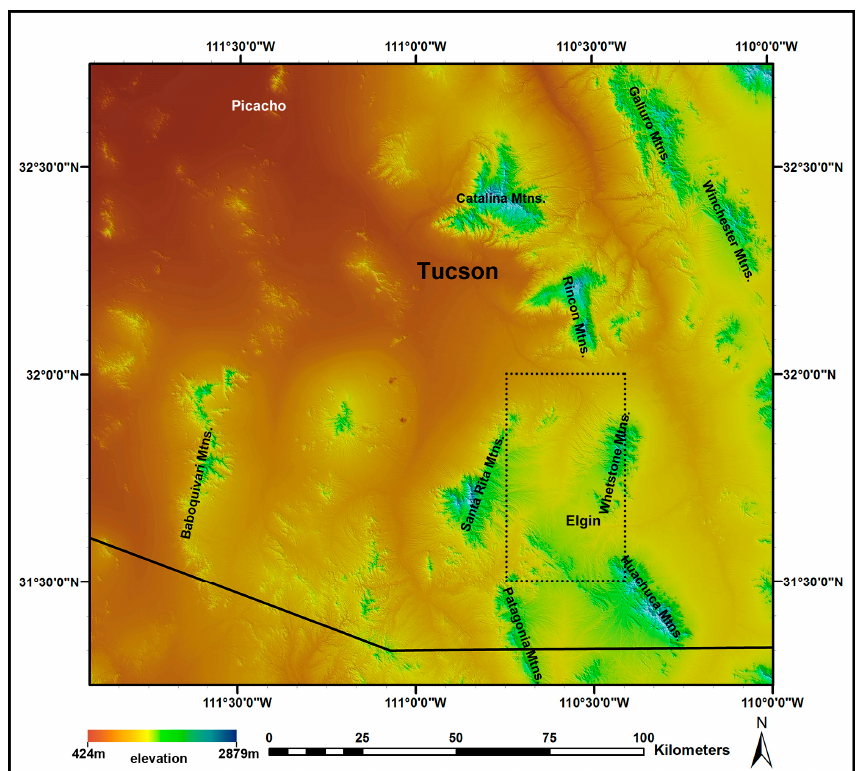
Figure 2. Topographic elevation across the study area with locations indicated for the Tucson metropolitan area, the communities of Picacho and Elgin, Arizona, and major sky island mountain ranges. The MODIS-based analysis encompassed the full extent of the map; the area of the Landsat-based analysis is indicated by the broken line. Table 1. Common Grass Species Occurring in Southern Arizona